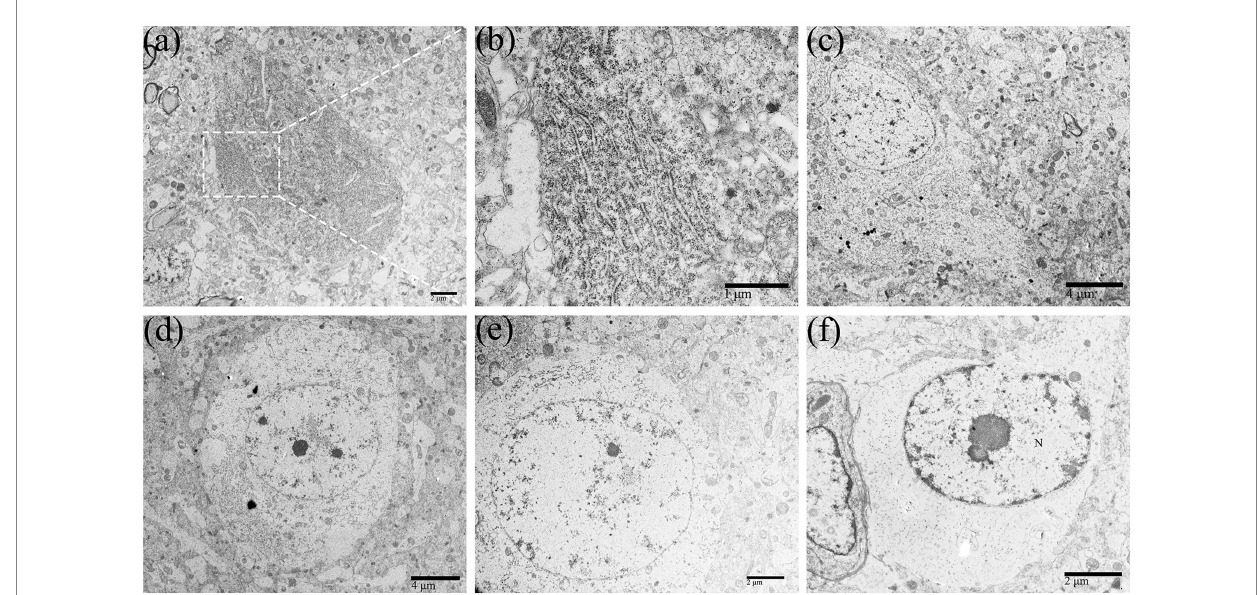
FIGURE 2 The perikaryon showed degenerative changes in DTMUV-infected neurons in the duckling brain. The organelles in the perikaryon (such as RER, Golgi apparatus, mitochondrion, etc.) were gradually decomposed and disappeared after undergoing morphological changes such as cystic dilation, vacuolation, and fragmentation, leaving the rarefied cytoplasm. (A) Normal neurons. (B) Lamellar arrangement of RER, also known as Nissl body. (C–F) The process of perikaryon degeneration. RER, rough endoplasmic reticulum.